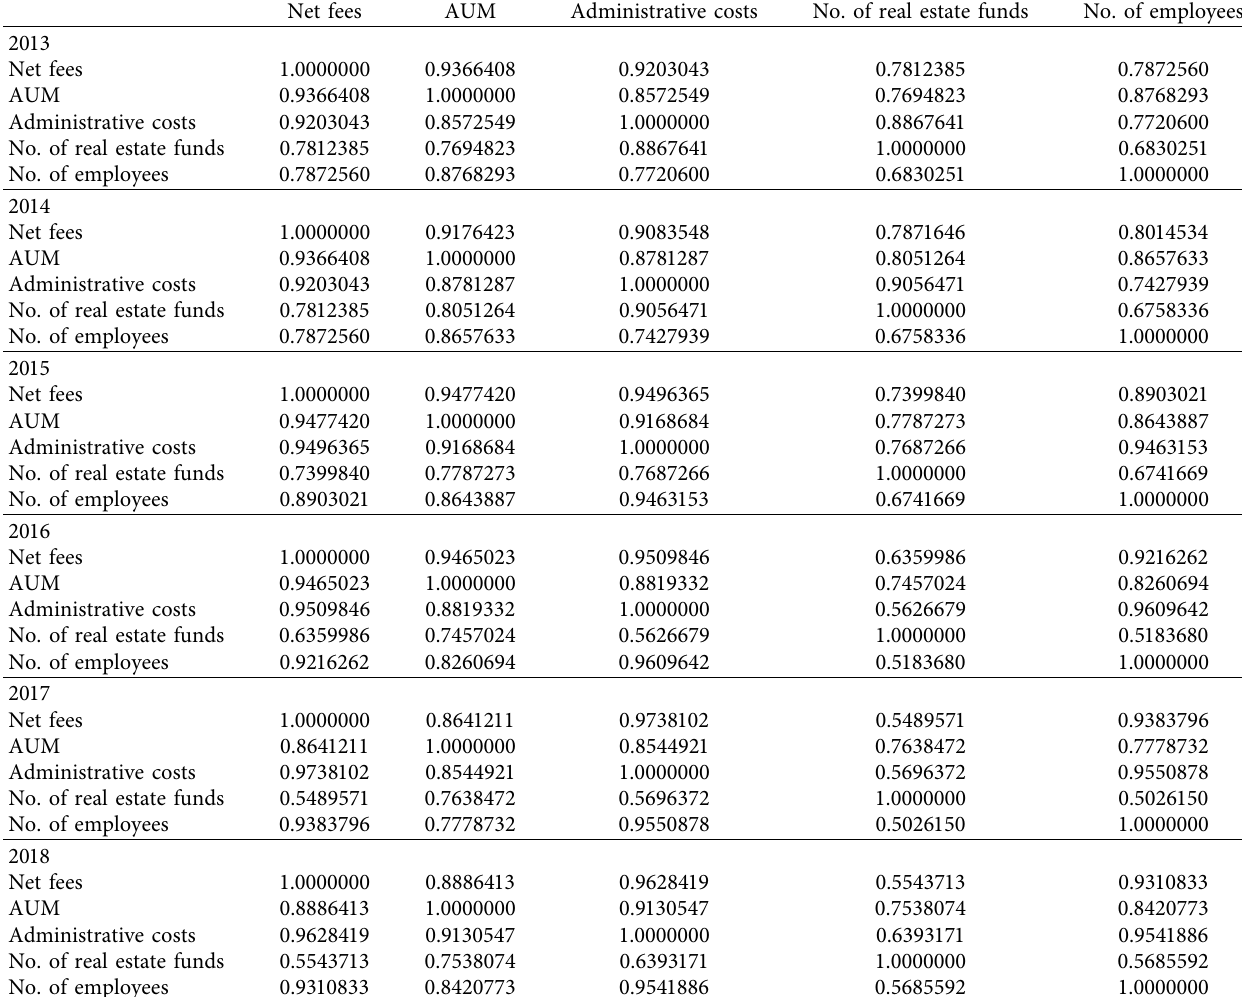
Table 1: Correlation matrix for each year.